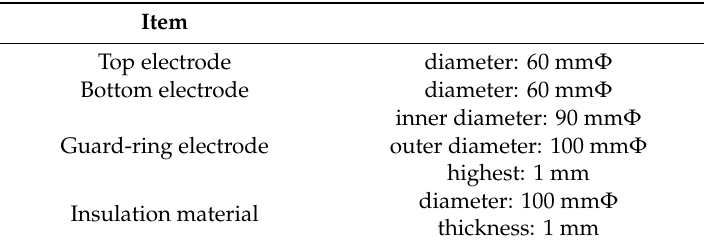
Table 1. Parameters of electrodes and insulating materials.